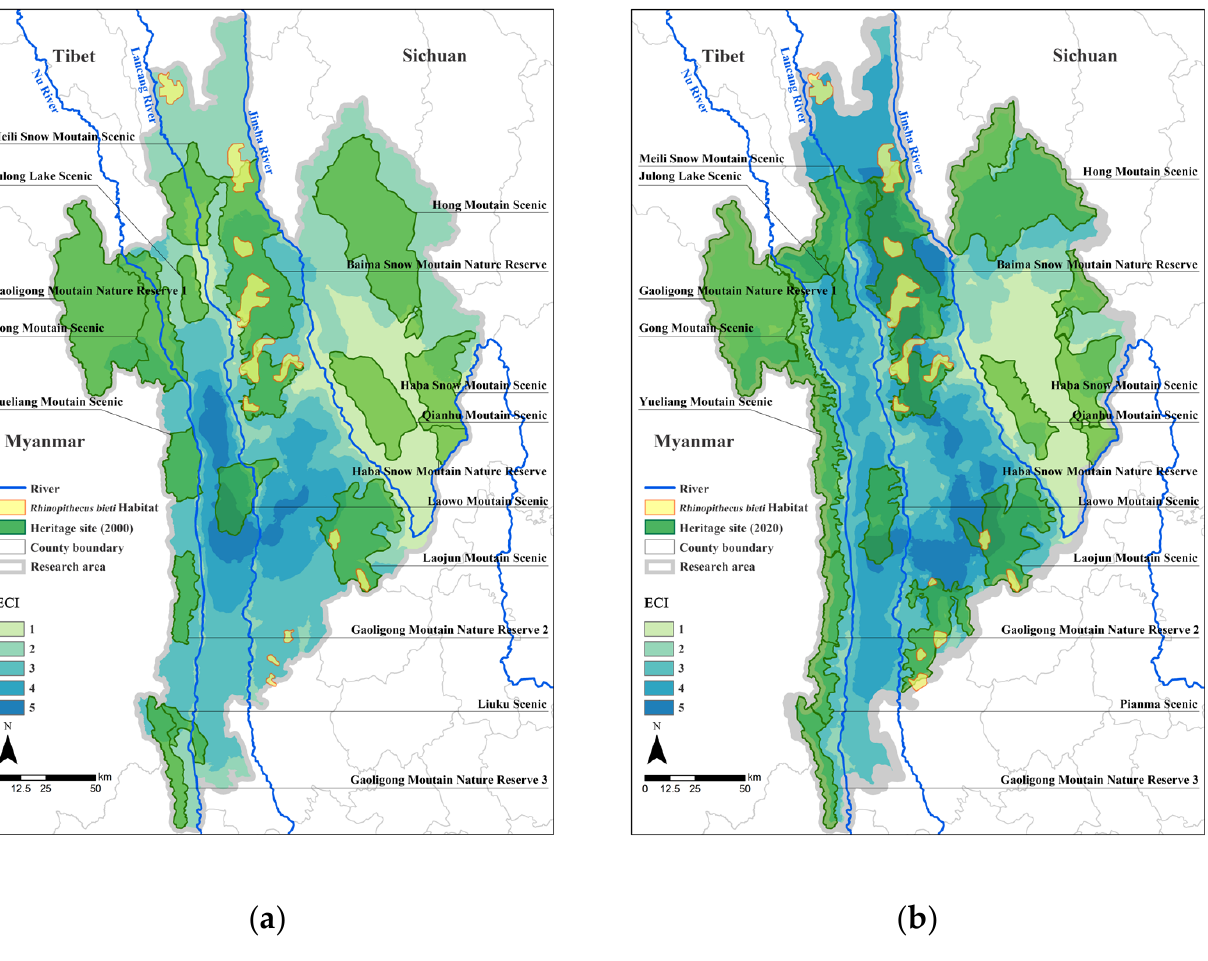
Figure 7. Map of the Three Parallel Rivers Natural World Heritage Site in 2000 ( a ) and 2020 ( b ) with ECI. The boundaries of the Three Parallel Rivers Natural World Heritage Site are drawn with reference to the 2001 Master Plan of the Three Parallel Rivers Scenic Area of the Nu, Lancang, and Jinsha rivers prepared by the Yunnan Provincial Institute of Urban and Rural Planning and Design and the 2011 Revision of the Master Plan of the Three Parallel Rivers Scenic Area of Yunnan Province, as well as the UNESCO map of heritage sites (https://whc.unesco.org/(accessed